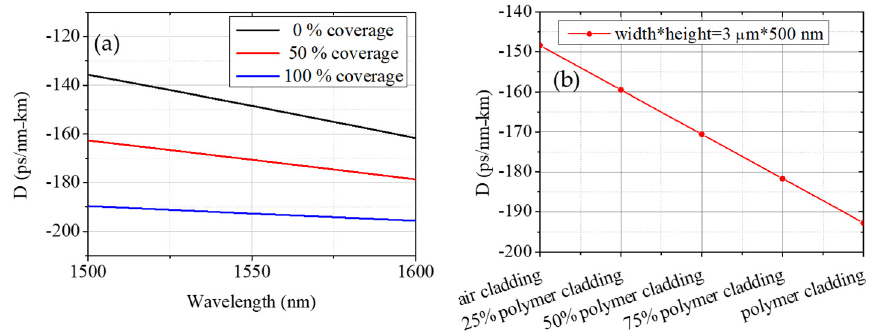
Figure 4. ( a ) Dispersion with 0 %, 50%, and 100 % coverage of polymer-cladding on the microresonator with 500 nm height and 3 µ m width. ( b ) The corresponding dispersion dependency on the cladding coverage at 1550 nm.